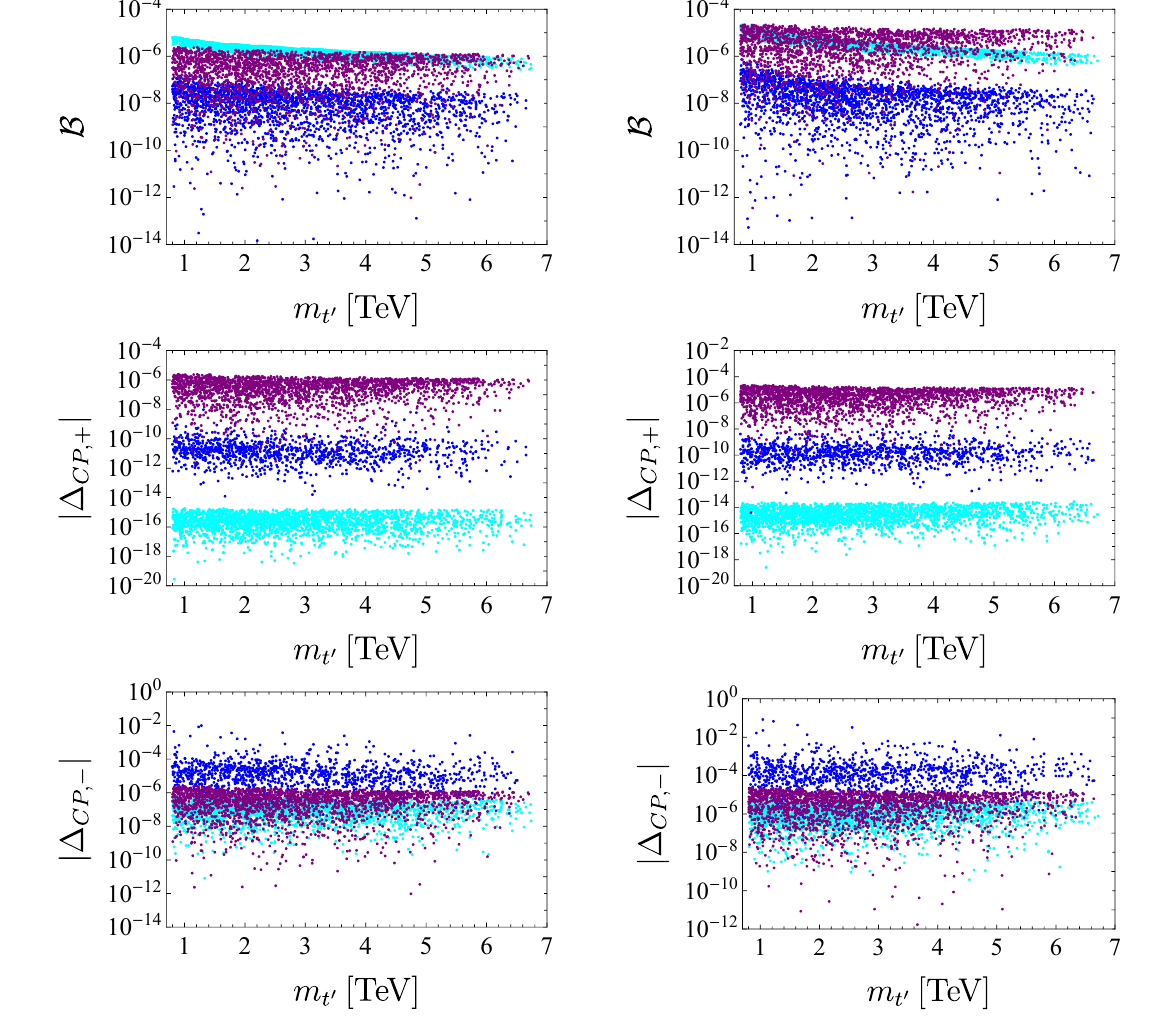
Figure 3 . The branching ratio (top panels), the | ∆ CP, + | asymmetry (middle panels) and | ∆ CP, − | asymmetry (bottom panels) for the radiative decays of t 0 . The left (right) panels are for radiative decays with a final state photon (gluon). The cyan, blue and purple points correspond to t 0 decay channels with a u , c and t quark final state respectively shown as a function of the vector-like quark mass m t 0 for the 3 σ parameter space described in ref.